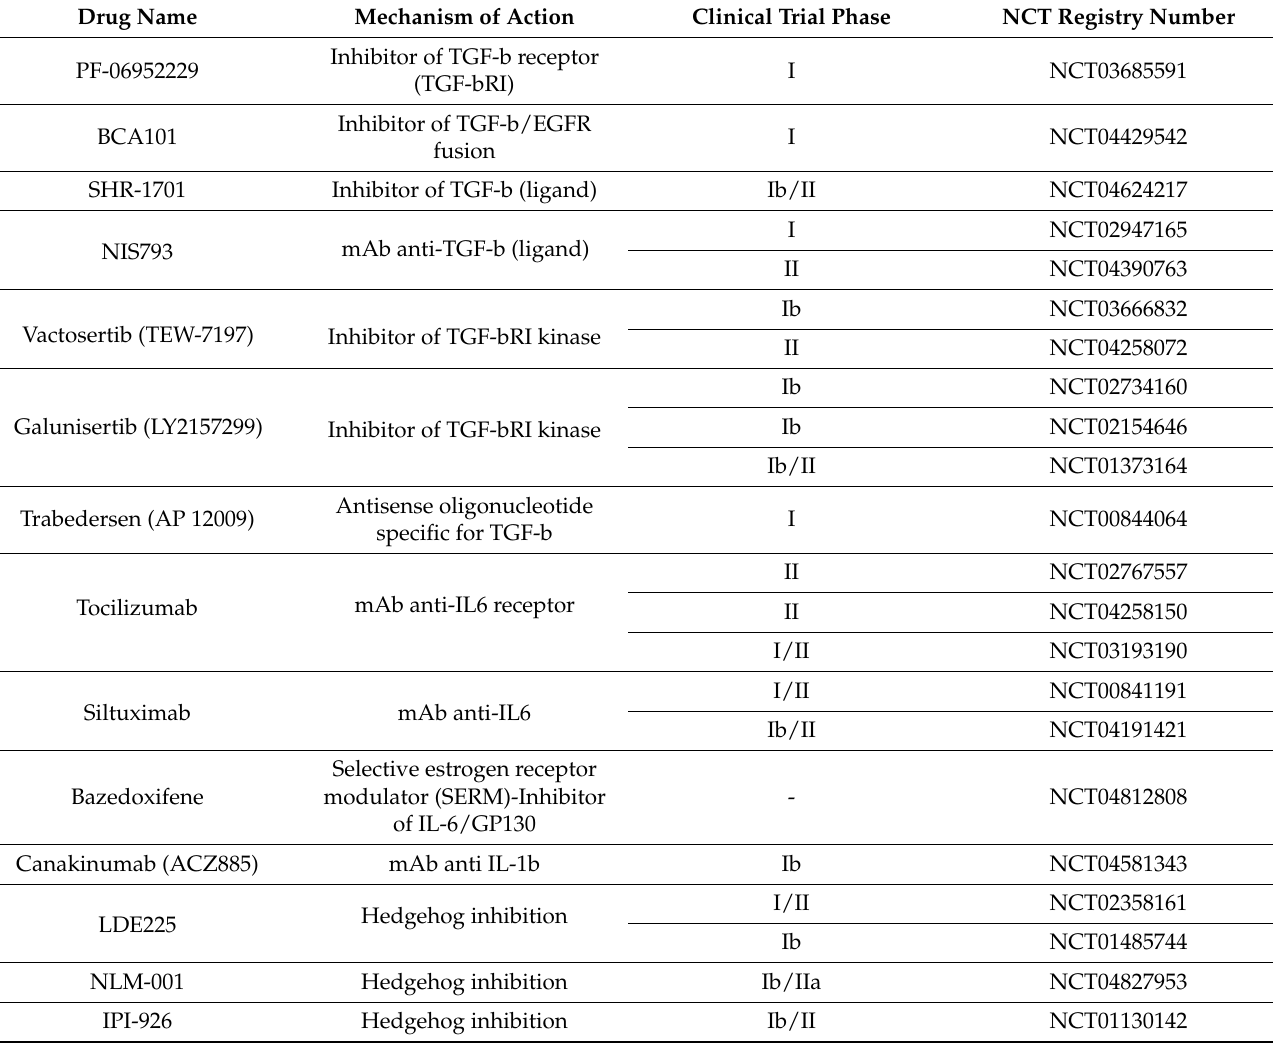
Table 4. Inhibitors and monoclonal antibodies targeting EMT, with different mechanisms of action, under clinical trials for